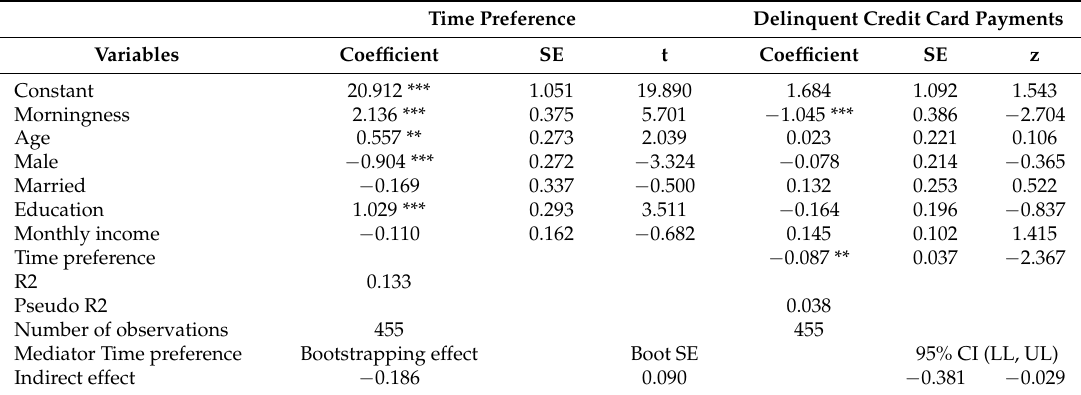
Table 4. The mediating effect of time preference on the relationship between morningness and delinquent credit card payments.